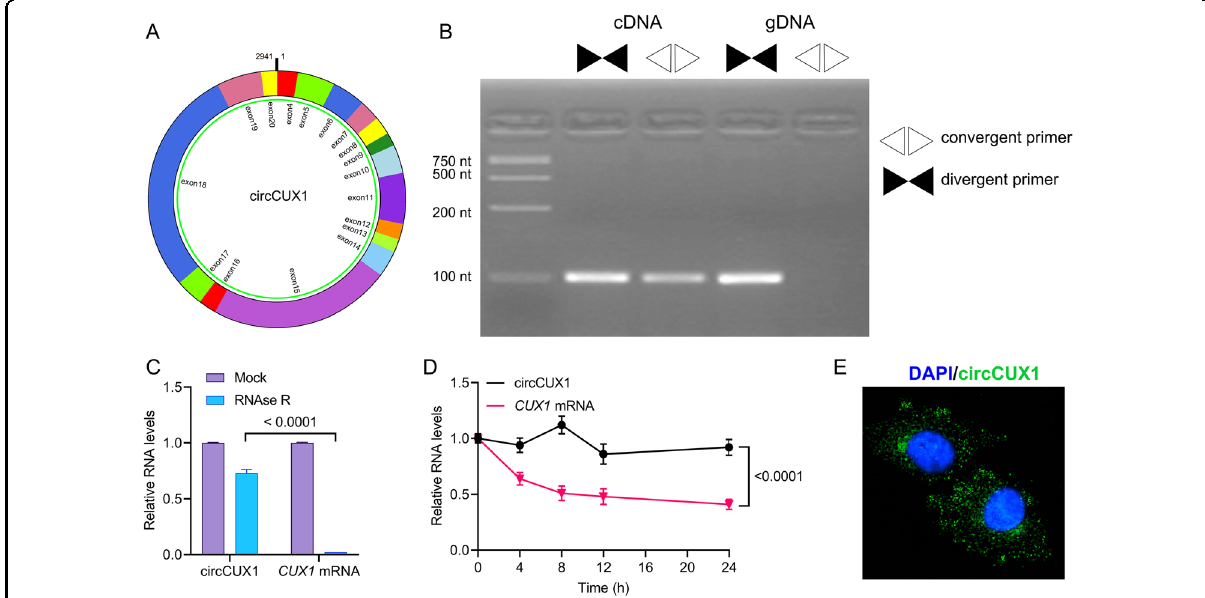
Fig. 3 Characterization of circCUX1 in HPSCC. A The circCUX1 structure. B qRT-PCR products with divergent primers showing circularization of circCUX1. cDNA complementary DNA, gDNA genomic DNA. C qRT-PCR analysis for the expression of circCUX1 and CUX1 mRNA after treatment with RNase R in Fadu cells. D qRT-PCR analysis for the expression of circCUX1 and CUX1 mRNAs after treatment with Actinomycin D at the indicated time points in Fadu cells. E RNA fl uorescence in situ hybridization for circCUX1. Nuclei were stained with